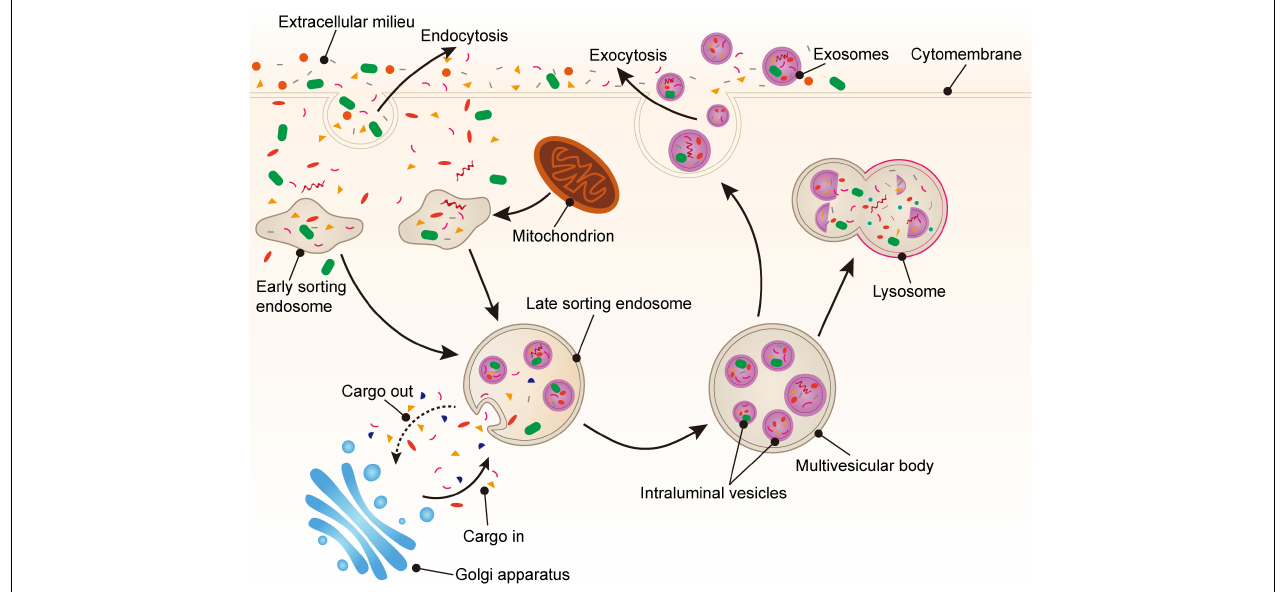
FIGURE 1 | Generation of platelet-derived exosomes. Extracellular proteins, lipids, and metabolites enter the cell through endocytosis. At the luminal side of the cell, the plasma membrane bulge from the outside to the inside to form early sorting endosomes (ESEs). Next, ESEs can fuse with other nucleosomes and transport substances through the Golgi apparatus, gradually forming late sorting endosomes (LSEs). Then, LSEs form intraluminal vesicles (ILVs) through plasma membrane invagination. Finally, the cargoes are further modified via the endosomal sorting complex required for transport (ESCRT) pathway or non-ESCRT pathway to eventually form multivesicular bodies (MVBs). MVBs fuse with the plasma membrane and secrete exosomes into the extracellular space via